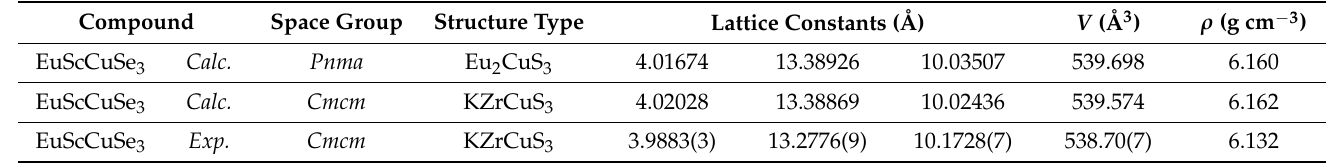
Table 3. Lattice parameters of EuScCuSe 3 obtained using PBE0 calculations.